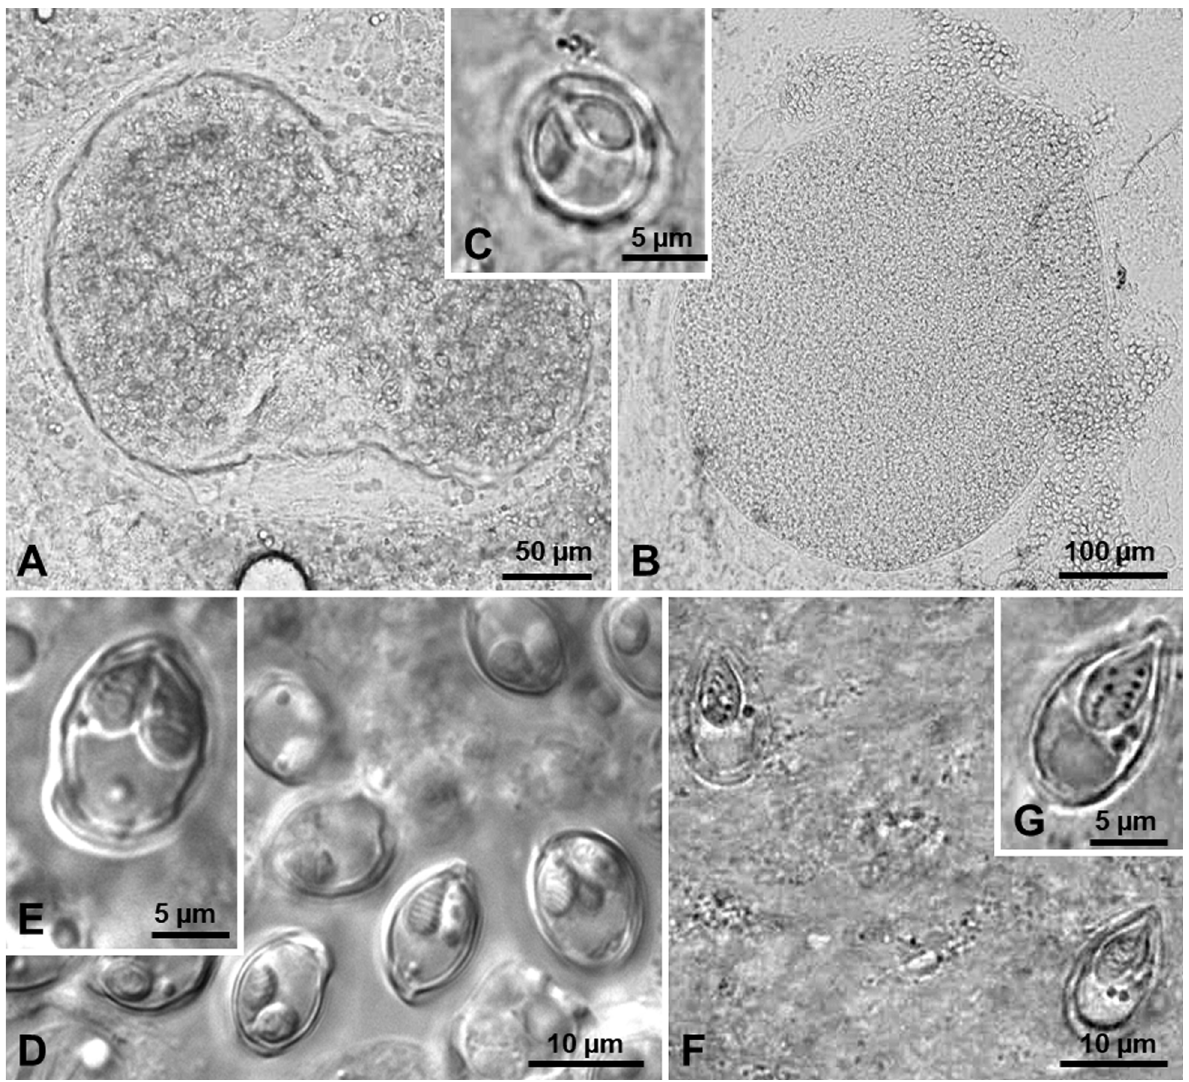
Figure 1. Light micrographs of wetmounts of the new myxobolid species found infecting Iberian endemic cypriniforms. (A – B) Cysts of Myxobolus arcasii n. sp. in the hematopoietic tissue of the kidneys, and in the undifferentiated tissue of the gonads of Achondrostoma arcasii , respectively. (C) Myxospore of Myxobolus arcasii n. sp. evidencing the two polar capsules in which the polar tubule coils. (D – E) Myxospores of Myxobolus duriensis n. sp. in the primary gill fi laments of Pseudochondrostoma duriense , evidencing the polar tubule coiling within the polar capsules, and the iodinophilous vacuole in the sporoplasm. (F – G) Myxospores of Thelohanellus paludicus n. sp. in the intestinal epithelium of Cobitis paludica , showing the polar tubule coiling within the polar capsule, and the two conspicuous iodinophilous vacuoles in the